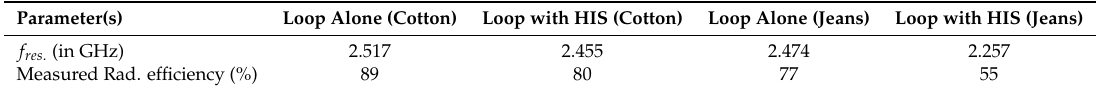
Figure 23. Images of the experimental setup for efficiency measurement of the textile loop sensor with and without HIS surface (case 4), ( a ) top view and ( b ) perspective view of the cylindrical-shaped wheeler cap. Table 2. Comparison of measured radiation efficiency for wearable loop antennas with HIS structure as compared against ungrounded wearable loop antennas.